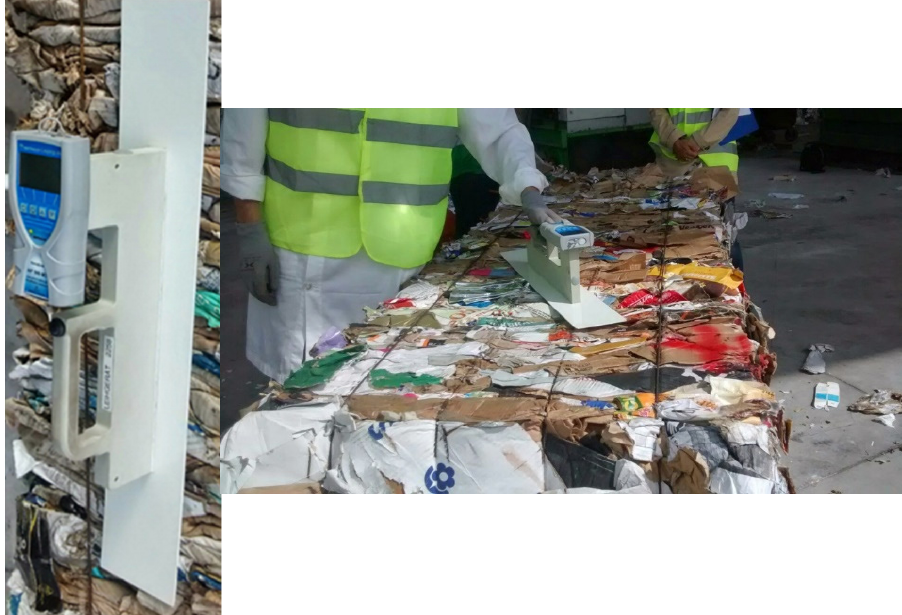
Figure 1. Equipment used in the project: EMCO ® model AP 500-M3.